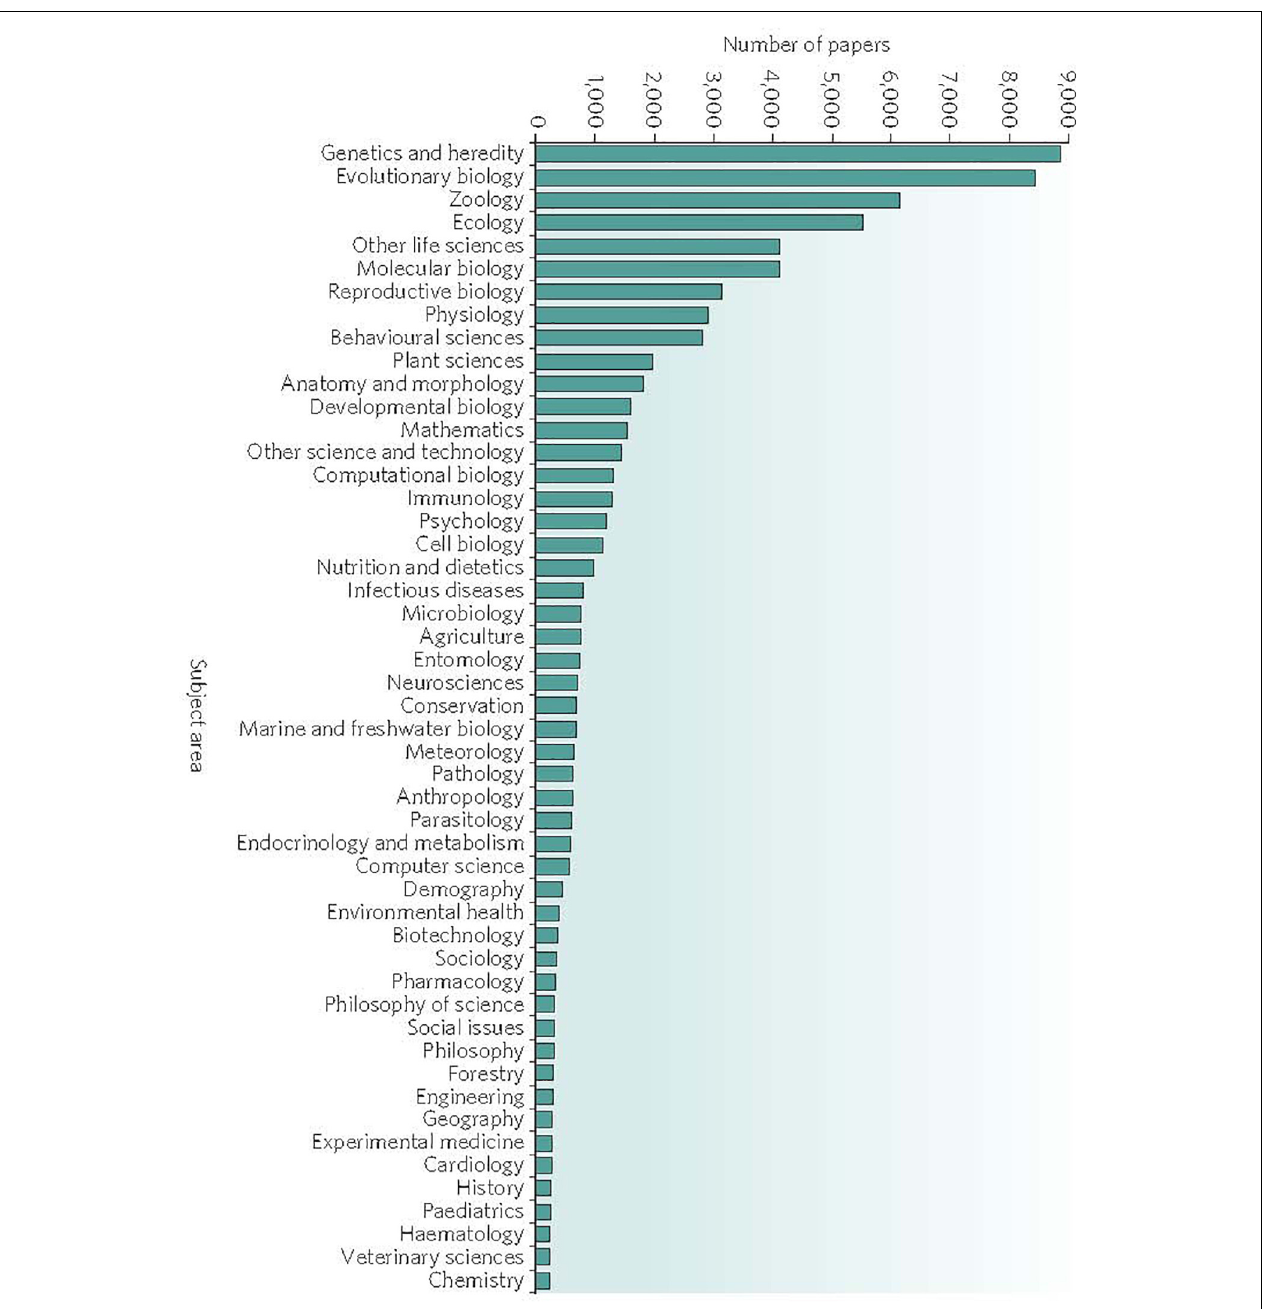
FIGURE 1 | Search by subject area completed in November 2008 by Mark Pagel on the ISI Web of Science data base as showing partial list ( ∼ 40,000) of scientific papers that include the term “natural selection” in their title, abstract or key words. Reprinted with permission from Springer Nature (Pagel, 2009). Note that the subject area “Genetics and Heredity” generated the largest number of published papers. Epigenetics does not appear on the list. By contrast, a 2019 search for the words “natural selection” and “genetics” on PubMed returned over 7,000 papers, whereas a search for “natural selection” and “epigenetics” returned only 65